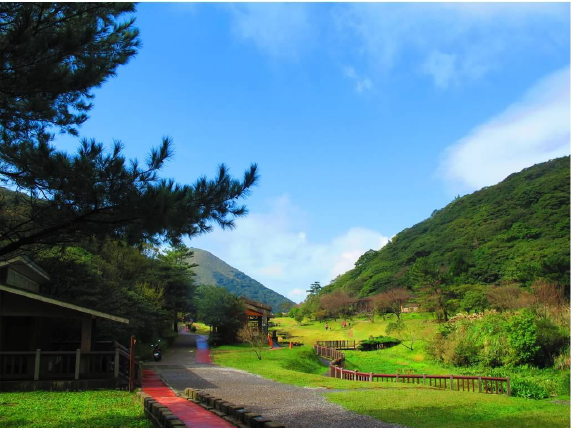
Figure 5. The Erziping Trail in Yangmingshan National Park 4 One kind of basalt, reddish-brown, with many